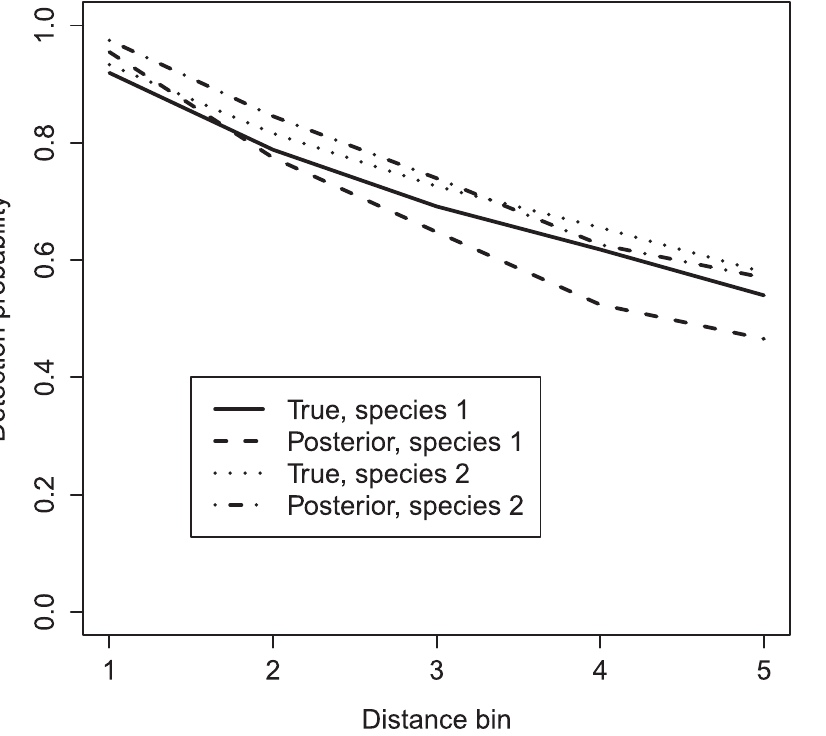
Figure 6. True and estimated detection functions for simulated data. Detection functions for each species are based on mean group sizes for each species (4 and 2, respectively), and are made for observer 2 (who had an intermediate detective ability).